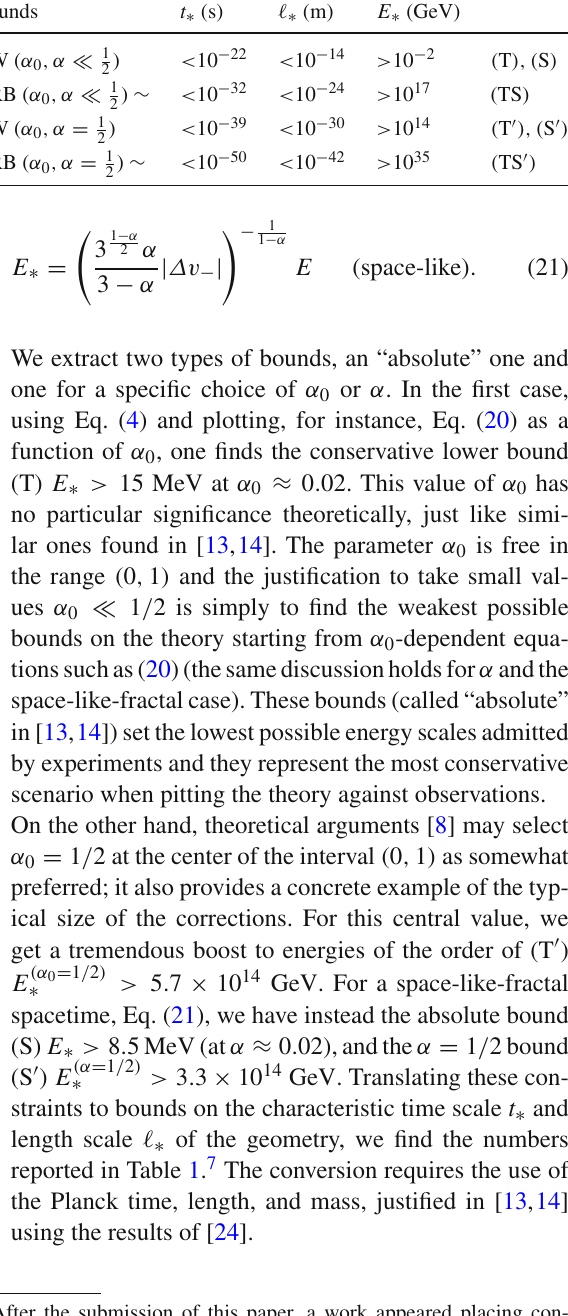
Table 1 Absolute and α 0 ,α = 1 / 2 bounds on the scale hierarchy of the theory with q -derivatives without log oscillations. Energy bounds are obtained directly from GWs or GRBs without any unit conversion. All figures are rounded and “ ∼ ” indicates crude estimates